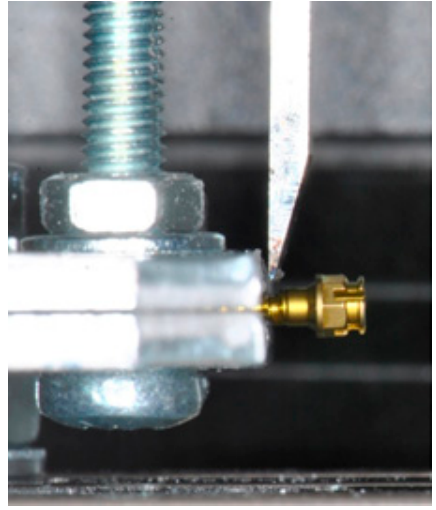
Figure 2. Photograph of the loading test set-up.